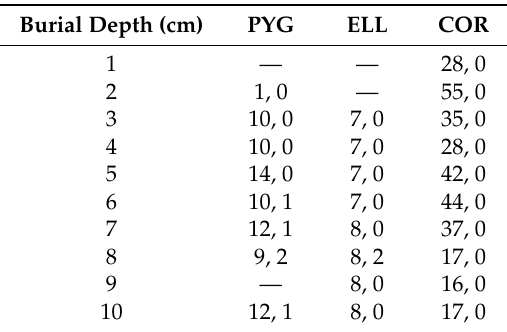
Table 4. Escape potential data for fine sand (2 Φ ≥ grain size ≥ 3 Φ ). PYG— Pyganodon cataracta ; ELL— Elliptio complanata ; COR— Corbicula fluminea. In columns 2–4, the number to the left of the